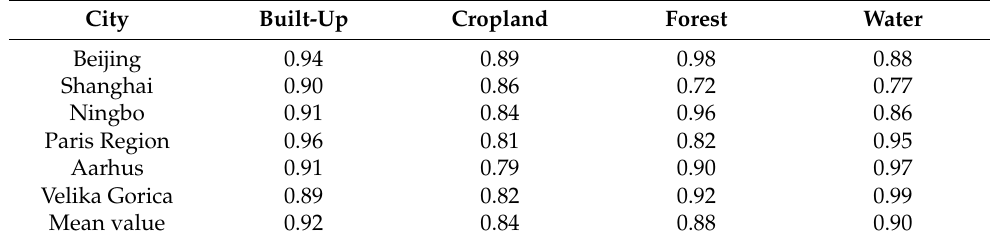
Table A2. ROC values for simulated land cover.